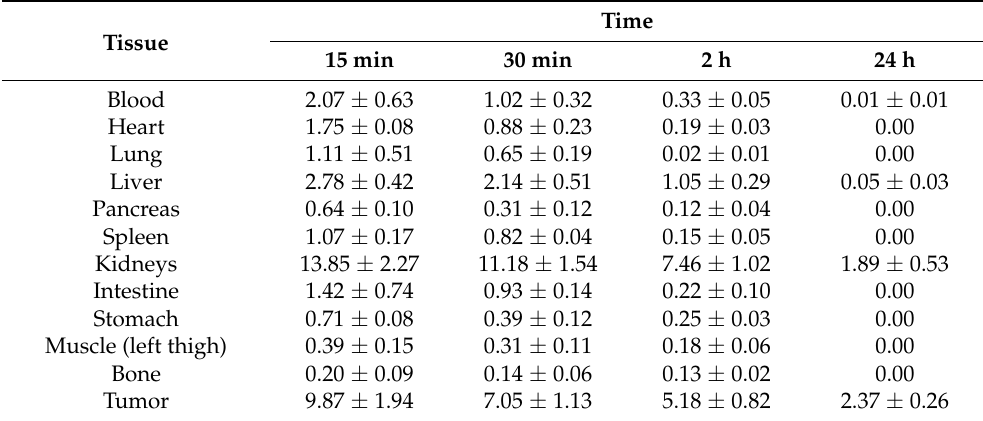
Table 2. Biodistribution of 99m Tc-iFAP in mice with induced Hep-G2 tumors, indicated as a percentage of injected dose per gram of tissue (%ID/g).